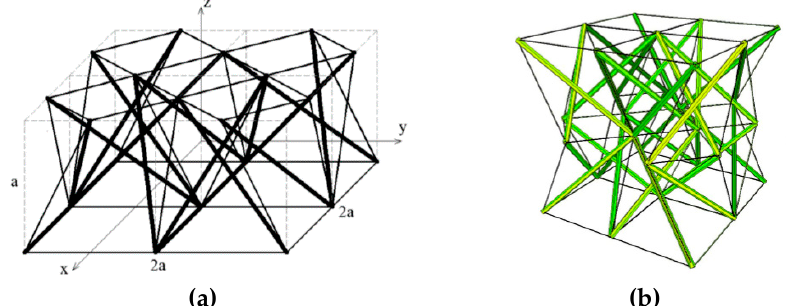
Figure 3. Double-layered tensegrity grids proposed by Al Sabouni-Zawadzka and Gilewski: ( a ) model from [39], ( b ) model from [41].